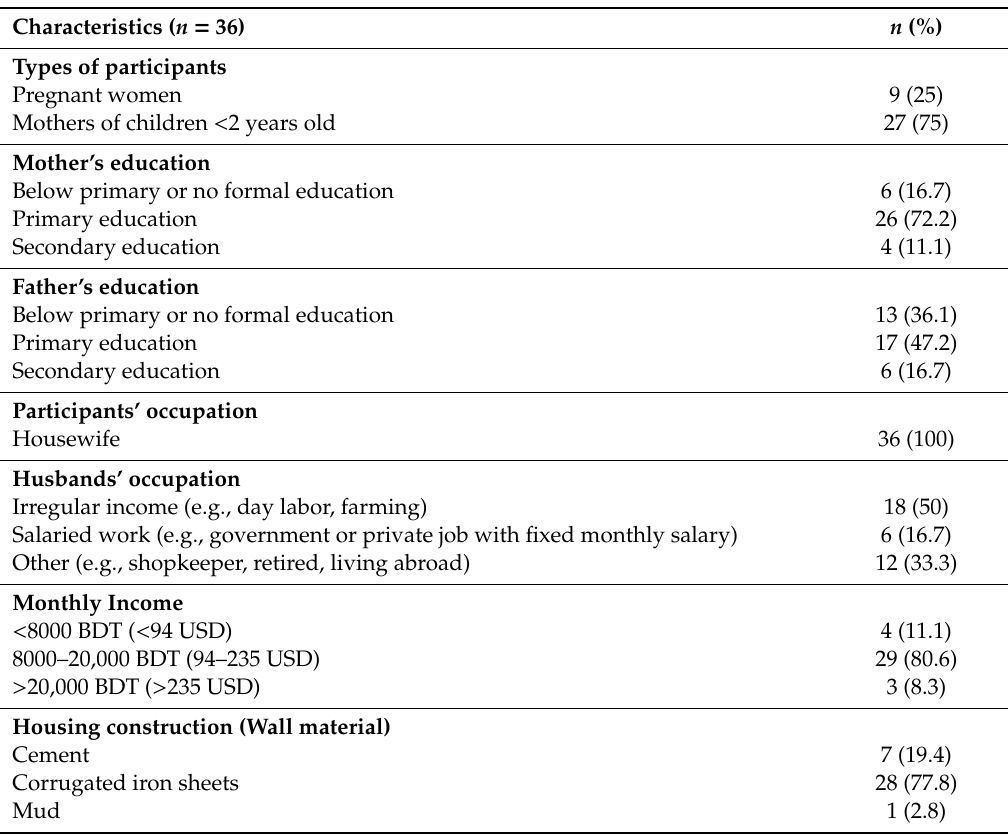
Table 3. Demographic characteristics of intervention